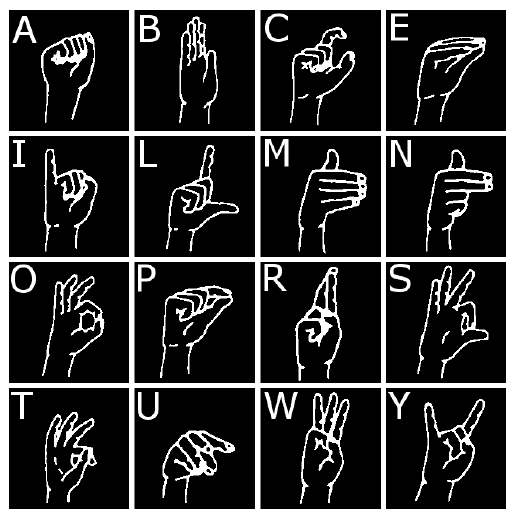
Figure 1. Letters of Polish finger alphabet represented by static